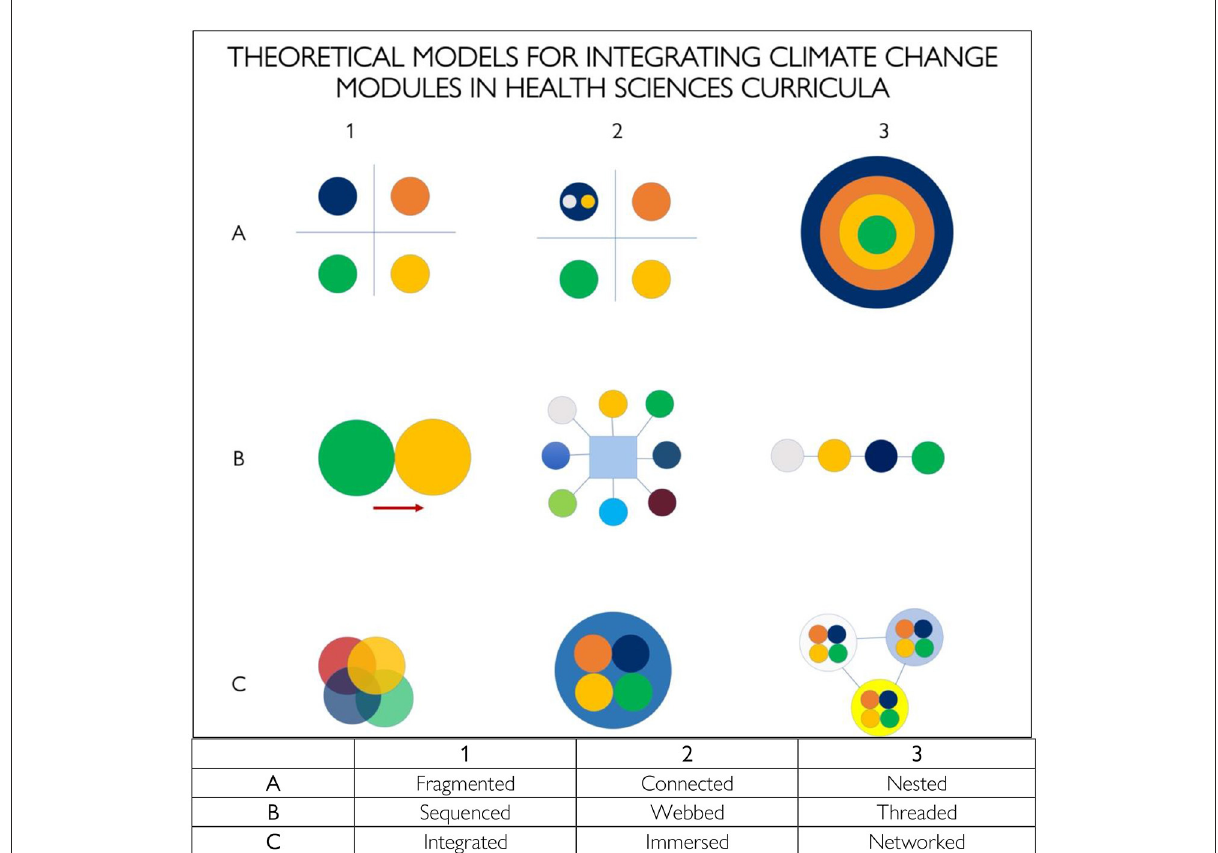
FIGURE1 Diagrams of curriculum integration models suitable for including climate change in curricula health sciences curricula (7). A1, A2, and A3 models are strategies for courses within a single discipline or professional training; B1, B2, B3, and C1 are ideal for interdisciplinary courses that bring students from various schools together for interprofessional education; C2 and C3 are ideal for continuing professional development